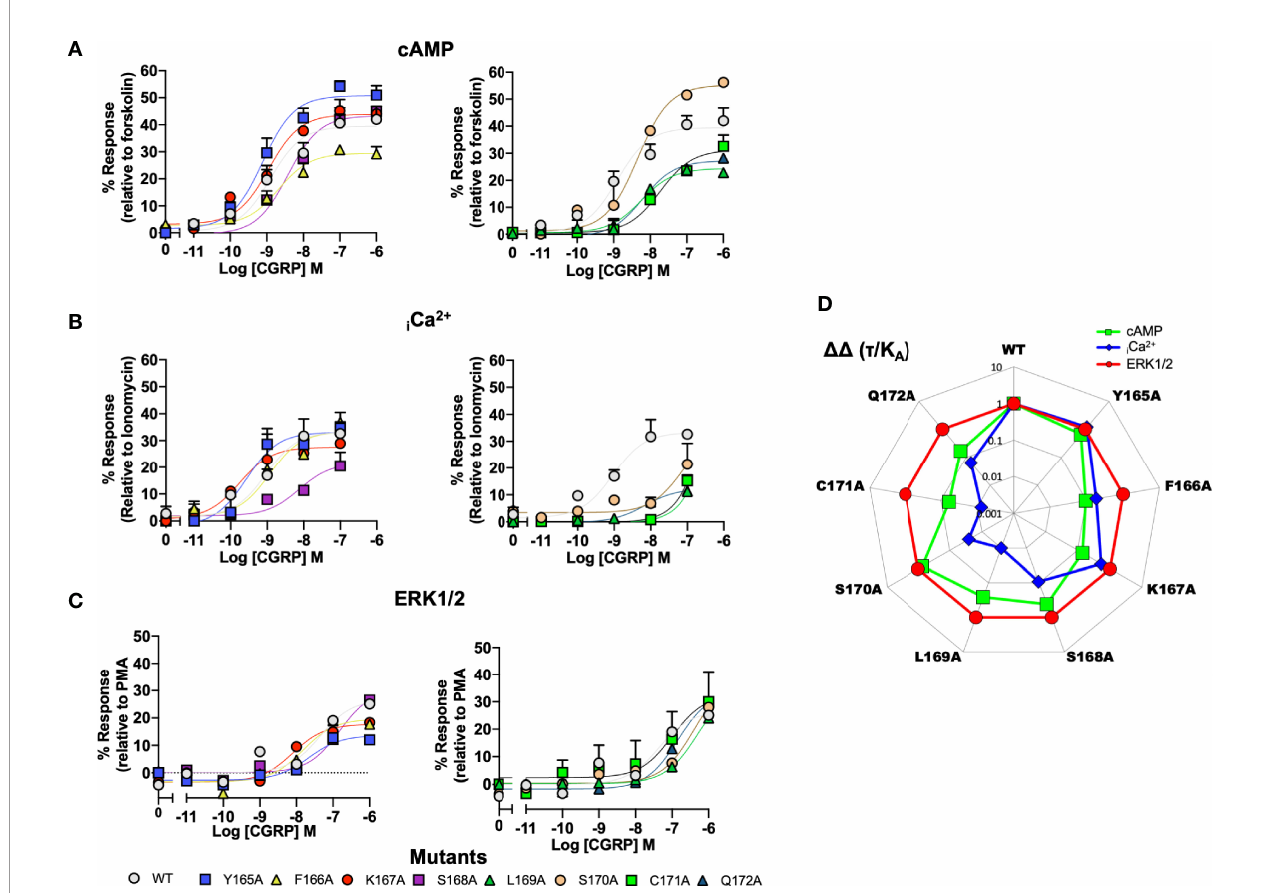
FIGURE 3 | Signaling bias of alanine mutants of ICL1 at the CGRP receptor. Residues in the ICL1 were mutated to Ala (except A393 where Leu was used) and the effects on (A) cAMP production, (B) elevation of intracellular Ca 2+ , (C) pERK were compared to wild type receptor, (D) Signaling bias plot was calculated as 10 DD ( t / KA) for each mutant and each signaling pathway relative to WT and ERK phosphorylation. Note I394A has not been included in the analysis due to a lack of signaling in the i Ca 2+ and ERK1/2 assays. All data are mean ± SEM of n repeats where n=minimum of 3